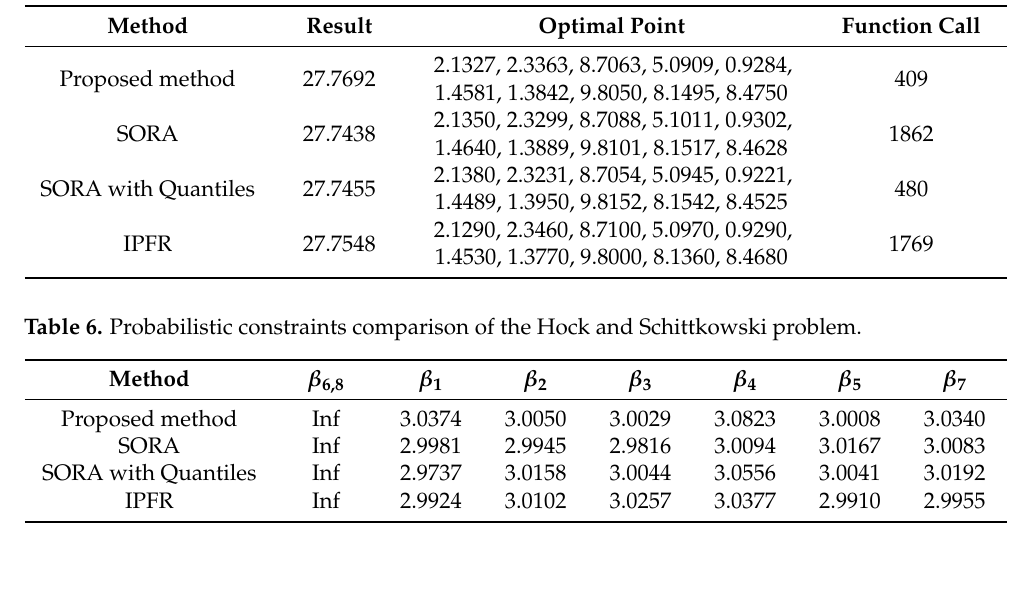
Table 5. Comparison results of the Hock and Schittkowski problem.